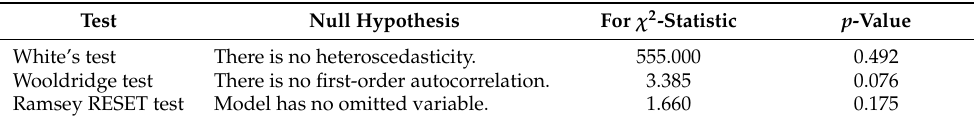
Table 4. The results of White’s test, Wooldridge test and Ramsey RESET test. Test Null Hypothesis For χ 2 -Statistic p -Value White’s test